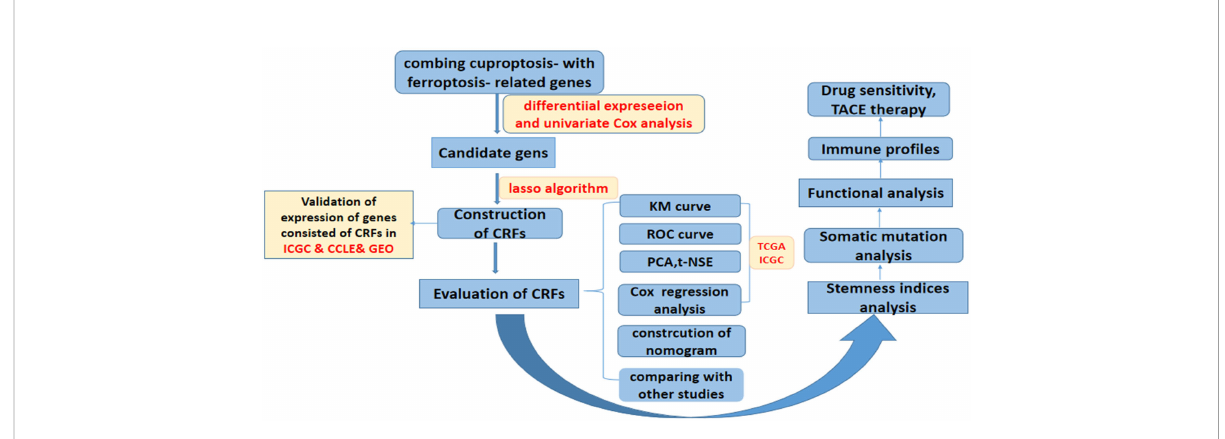
FIGURE 1 Flowchart of overall study